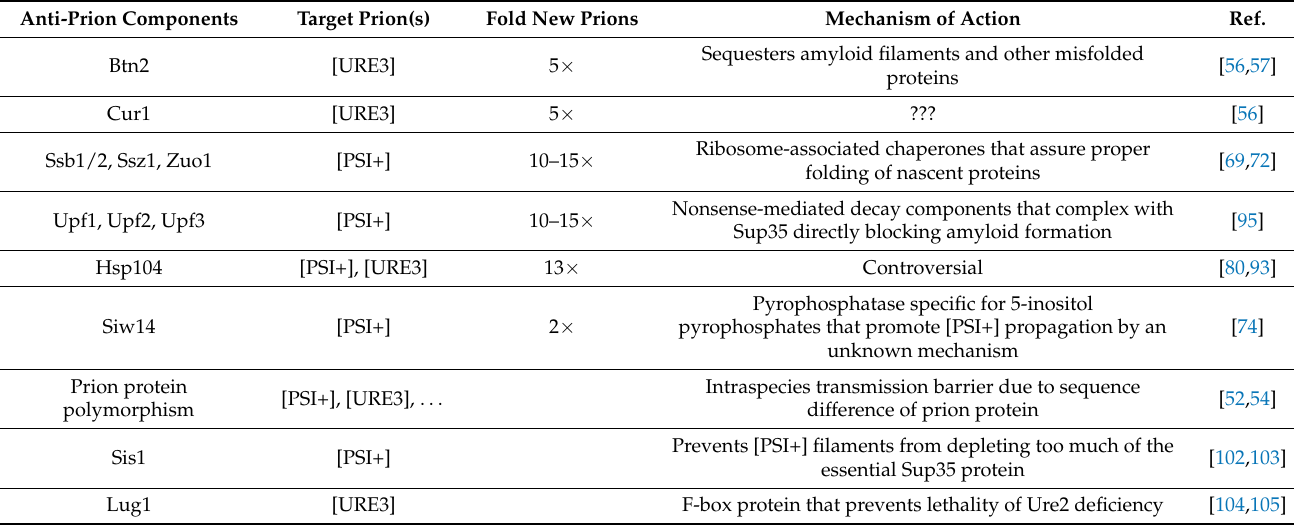
Table 1. Anti-prion systems in